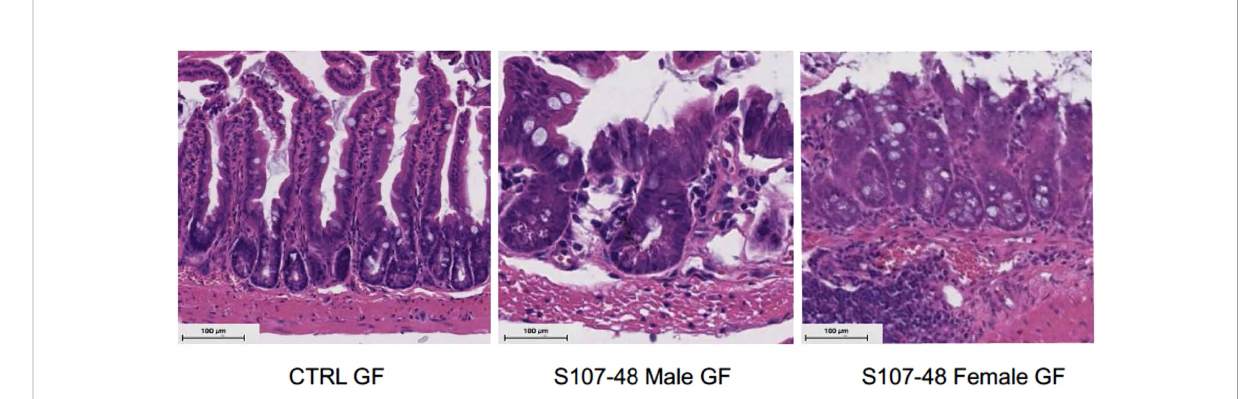
FIGURE 8 Neonatal RG colonization causes morphologic intestinal abnormalities and raised tight junction Occludin gene transcript levels. Representative H&E staining of terminal Ileum sections from litters of RG-colonized and control or GF mice, with comparisons of mice sacri fi ced at 14 weeks of age (n = 4 mice/group). S107-48 RG strain colonized mice, which were previously GF, demonstrate subjective fl attening of epithelial villi and reduced goblet cells at bases.